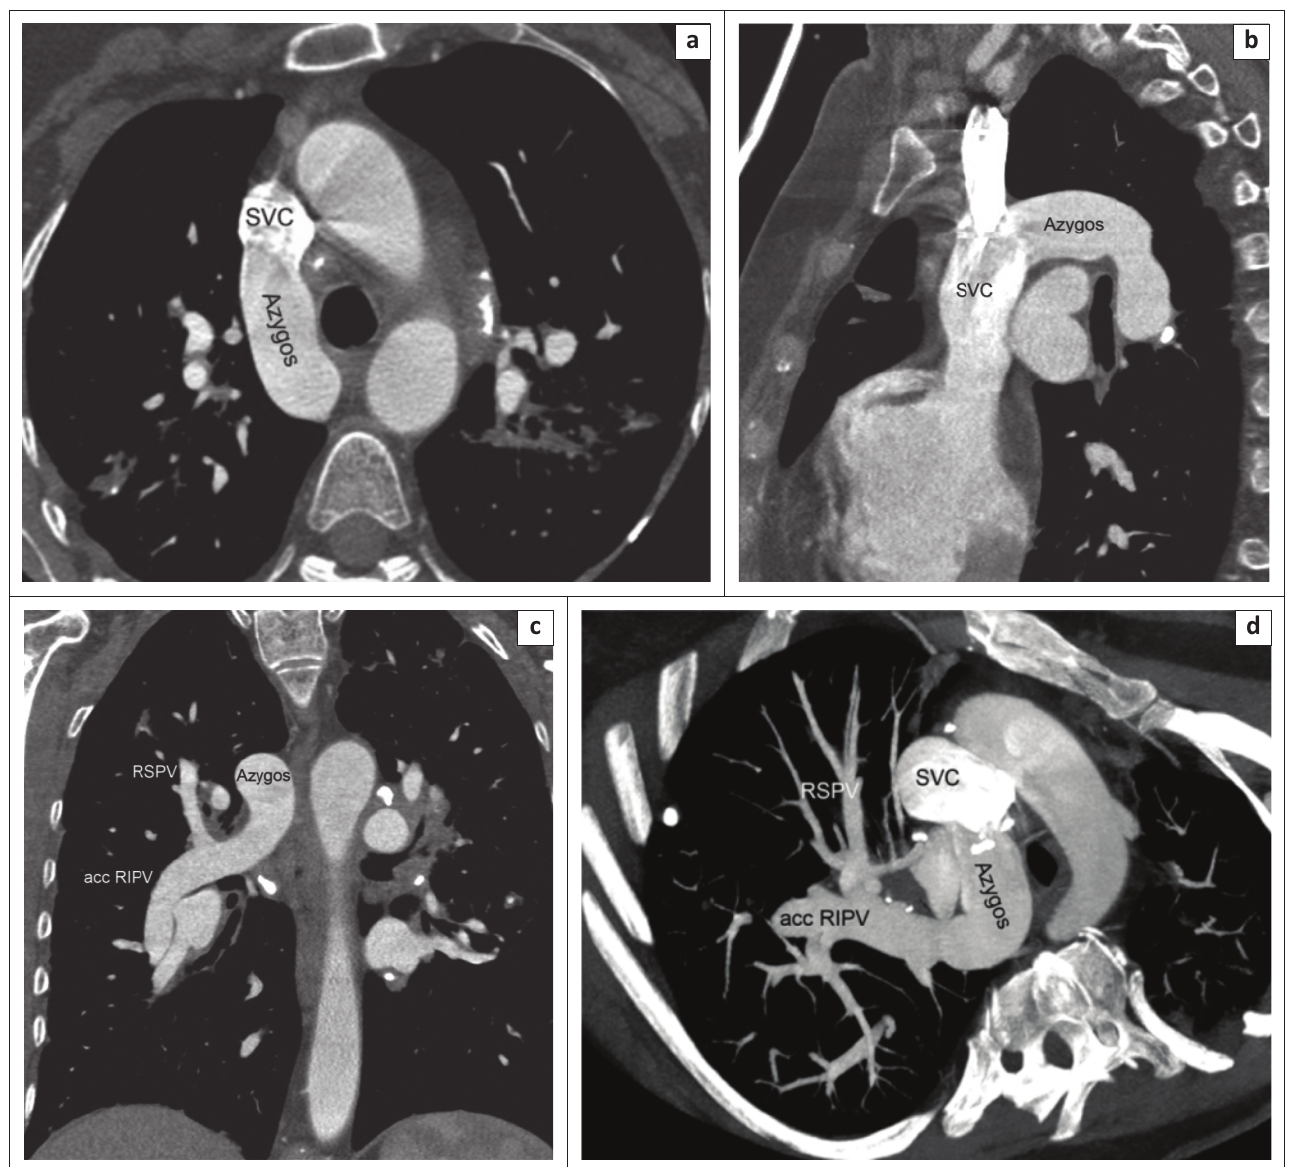
SVC, Superior vena cava; RSPV, right superior pulmonary vein. FIGURE 14: Partial anomalous pulmonary venous return in a 51-year-old woman. The right superior pulmonary vein and an accessory right inferior pulmonary vein drain into the superior vena cava (SVC) via the azygos vein: (a) Axial image; (b) Sagittal image; (c) Coronal image; (d) Oblique axial